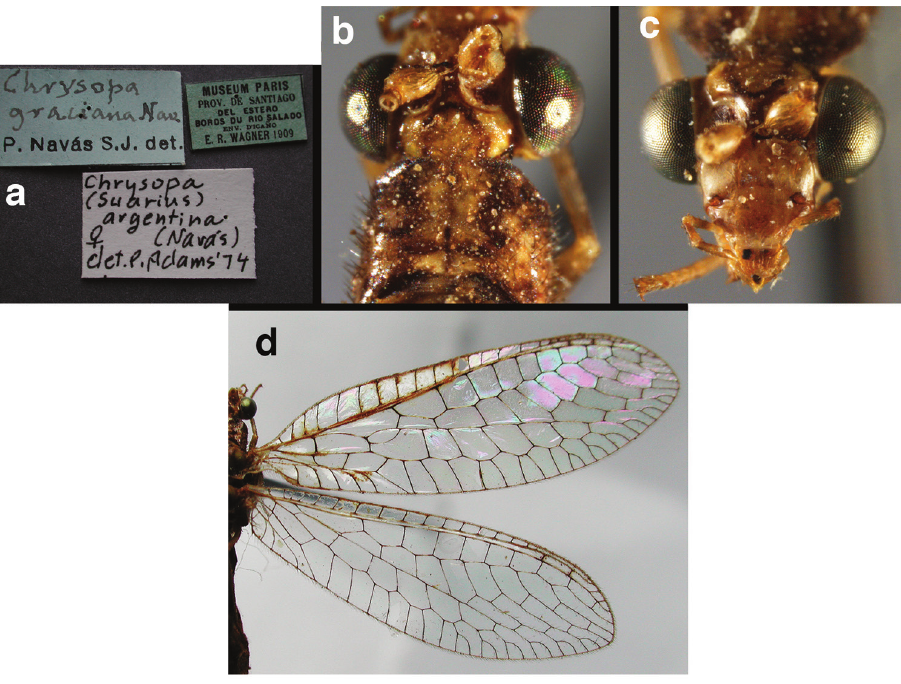
Figure 142. Chrysopa graciana Navás: Features of nontype specimen reported by Navás 1927: 21, a labels b head, dorsum c head, frontal d wings (Argentina, Santiago del Estero, female,